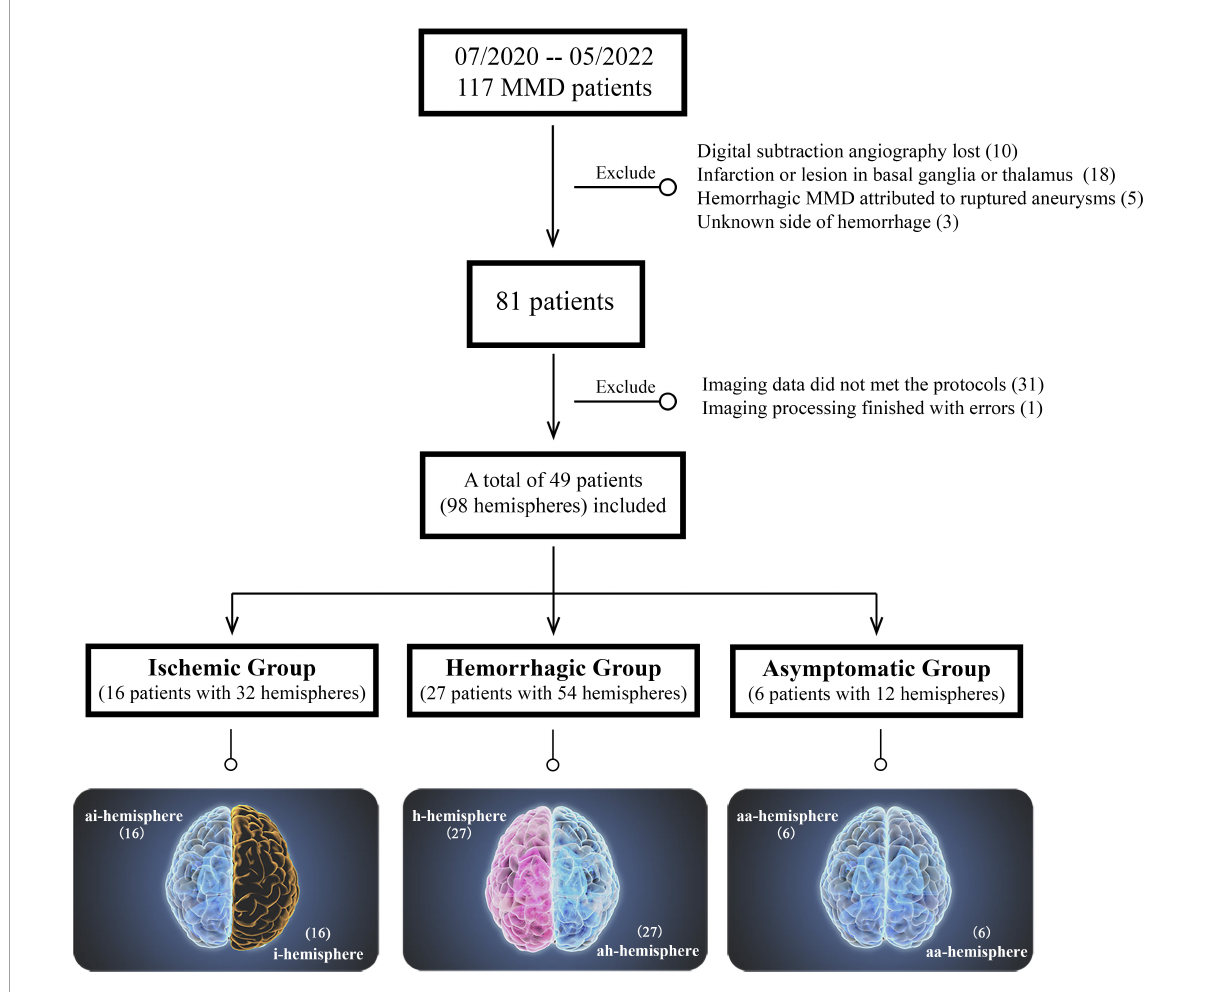
FIGURE1 Patients’ inclusion and exclusion flowchart. The bottom is the classification of different hemispheres in moyamoya disease (MMD).